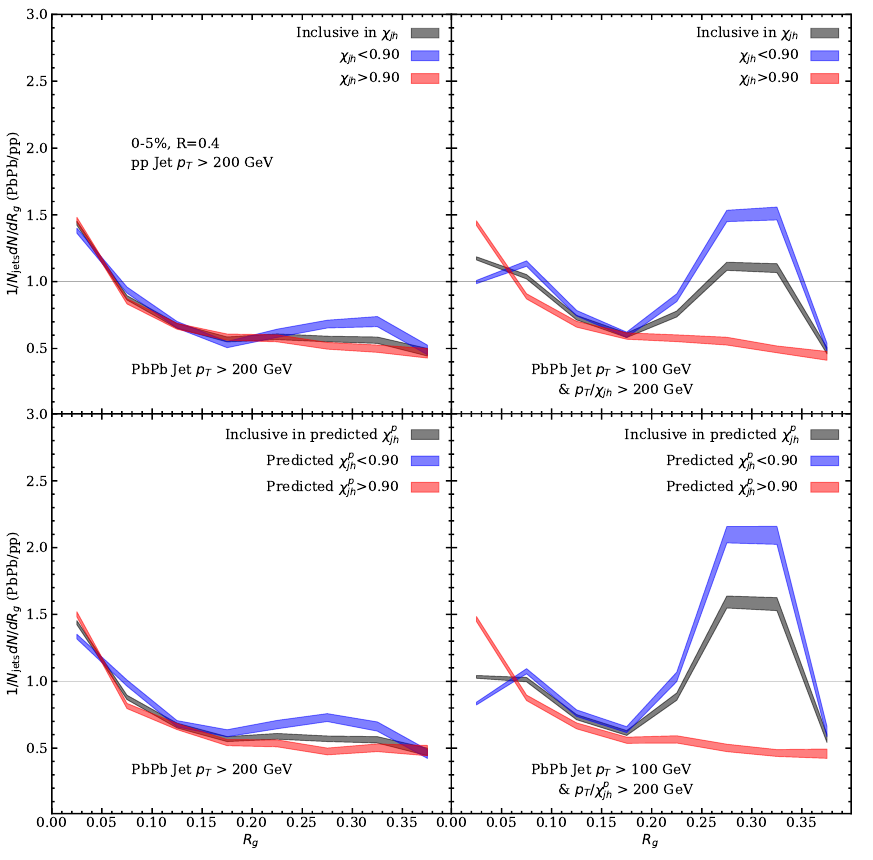
Figure 14 . Results comparing the R g ratio between PbPb and pp for the true χ jh (top row) and predicted χ p (bottom row), and the FES (left column) with the IES (right jh